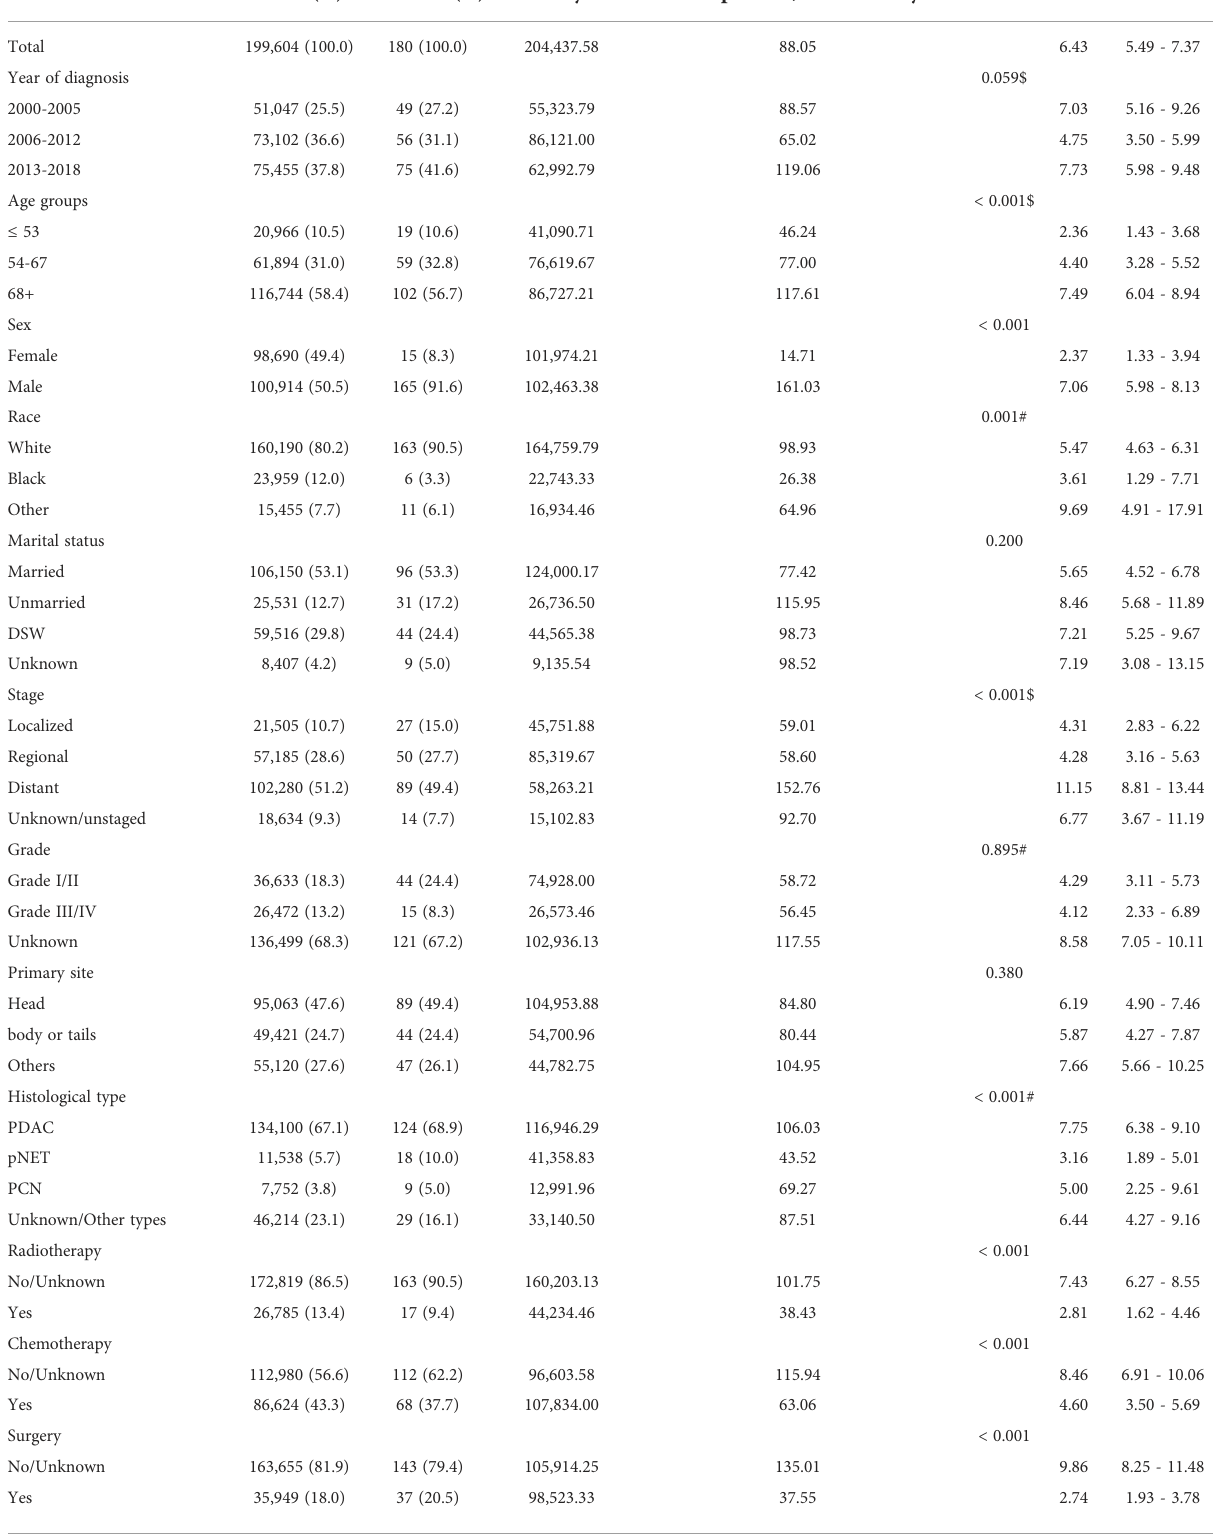
TABLE 1 Baseline characteristics, suicide rates, and standardized mortality ratios (SMR) among pancreatic cancer patients (2000-2018).